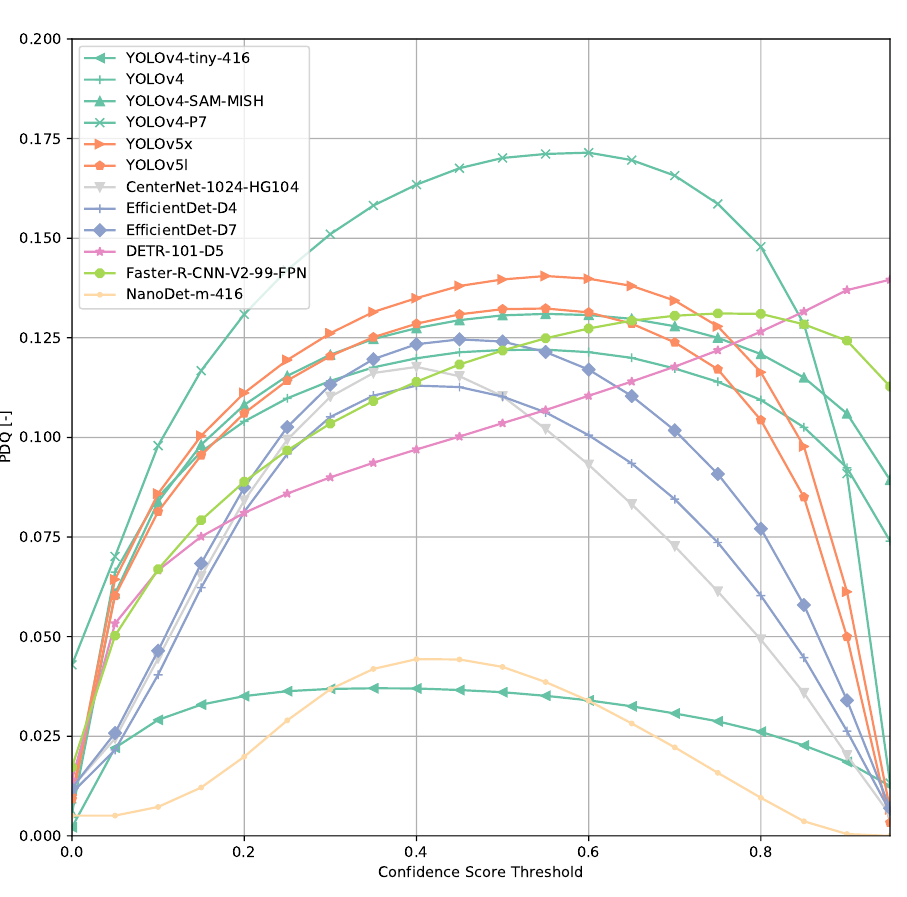
Figure 5. PDQ curves of selected subset of